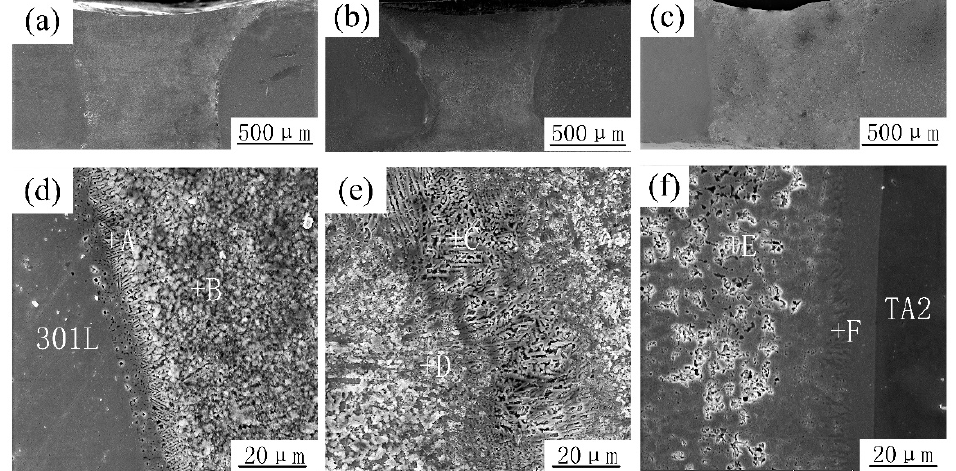
Figure 14. The cross-sectional morphologies and microstructures of 301L / Cu / TA2 welded joints: ( a – c ) The cross-sectional morphologies of 301L/Cu/TA2 welded joints based on laser offsets of − 0.3 mm, 0 mm, + 3 mm, respectively; ( d – f ) microstructures of welded joints on 301L side, welding center, TA2 side, respectively. Table 5. Spot EDS analysis of 301L/Cu/TA2 welded joints.